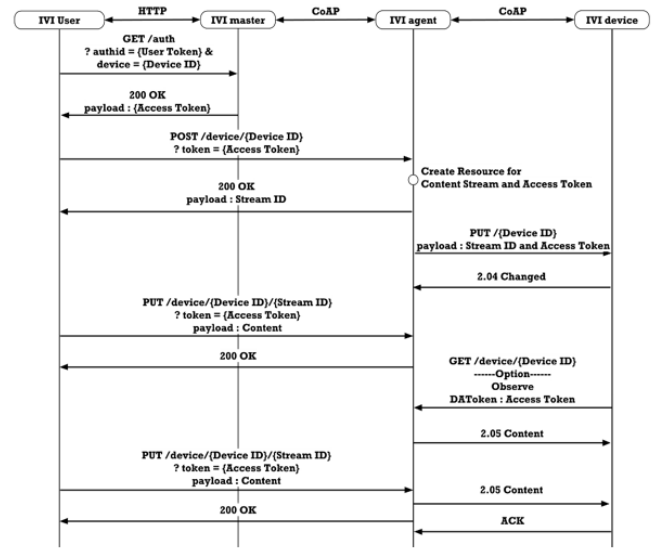
Figure 14. Operation flows for direct communication .